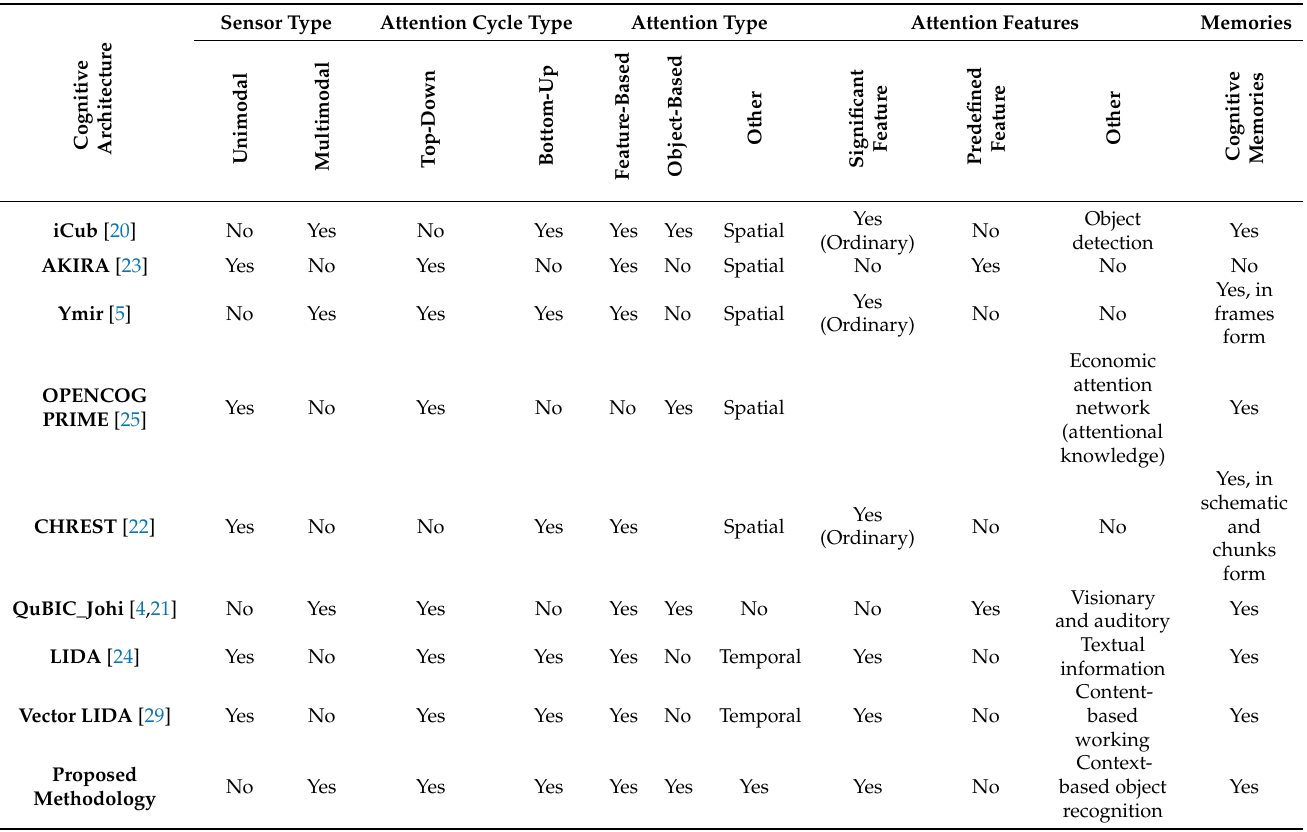
Table 1. Comparative analysis of different existing cognitive